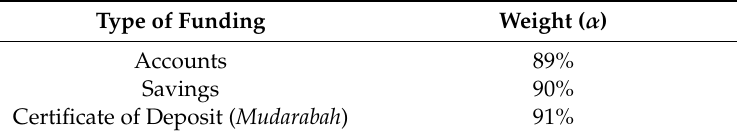
Table 2. Values of α for each type of